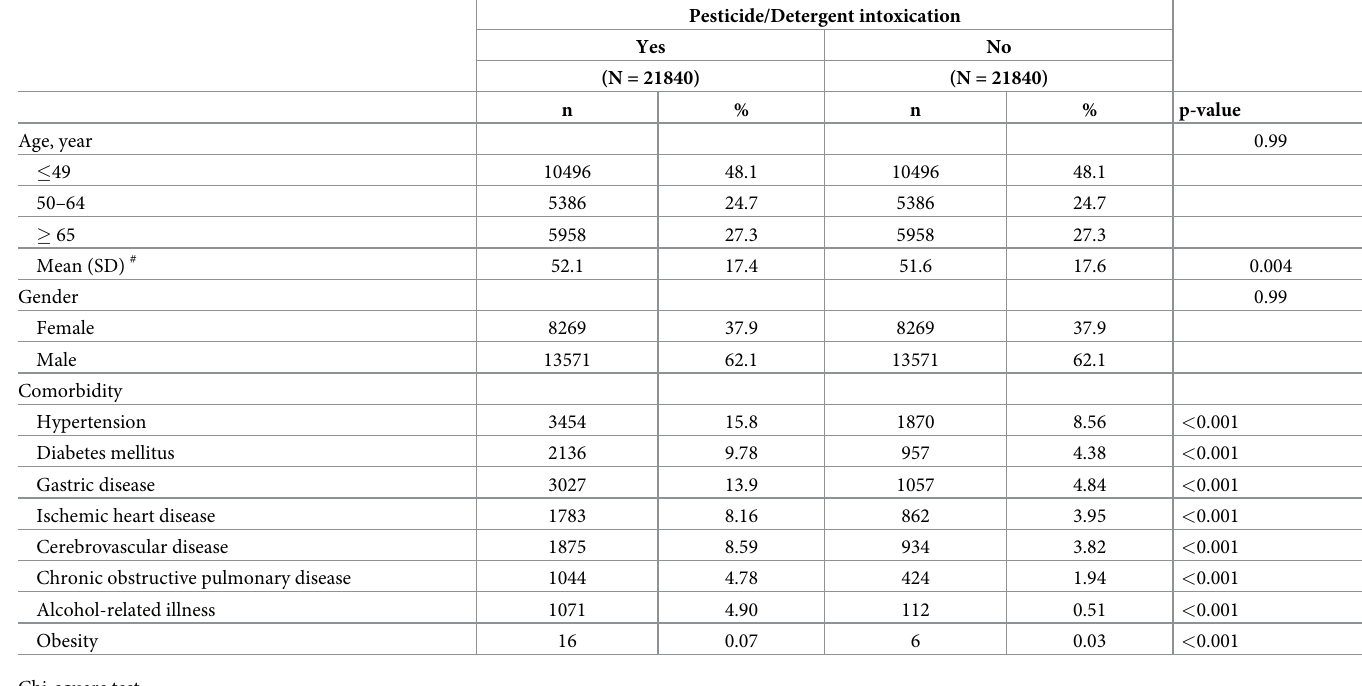
Table 1. Characteristics of patients with and without pesticide/detergent